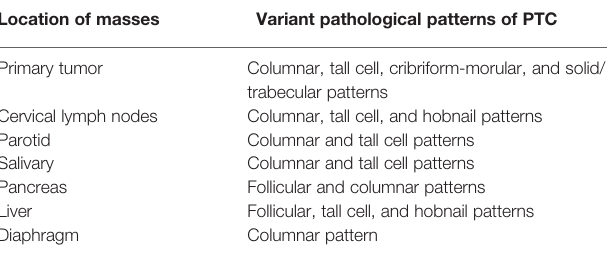
TABLE 1 | Variant pathological patterns of PTC in different lesions. Location of masses Variant pathological patterns of PTC Primary tumor Columnar, tall cell, cribriform-morular, and solid/ trabecular patterns Cervical lymph nodes Columnar, tall cell, and hobnail patterns Parotid Columnar and tall cell patterns Salivary Columnar and tall cell patterns Pancreas Follicular and columnar patterns